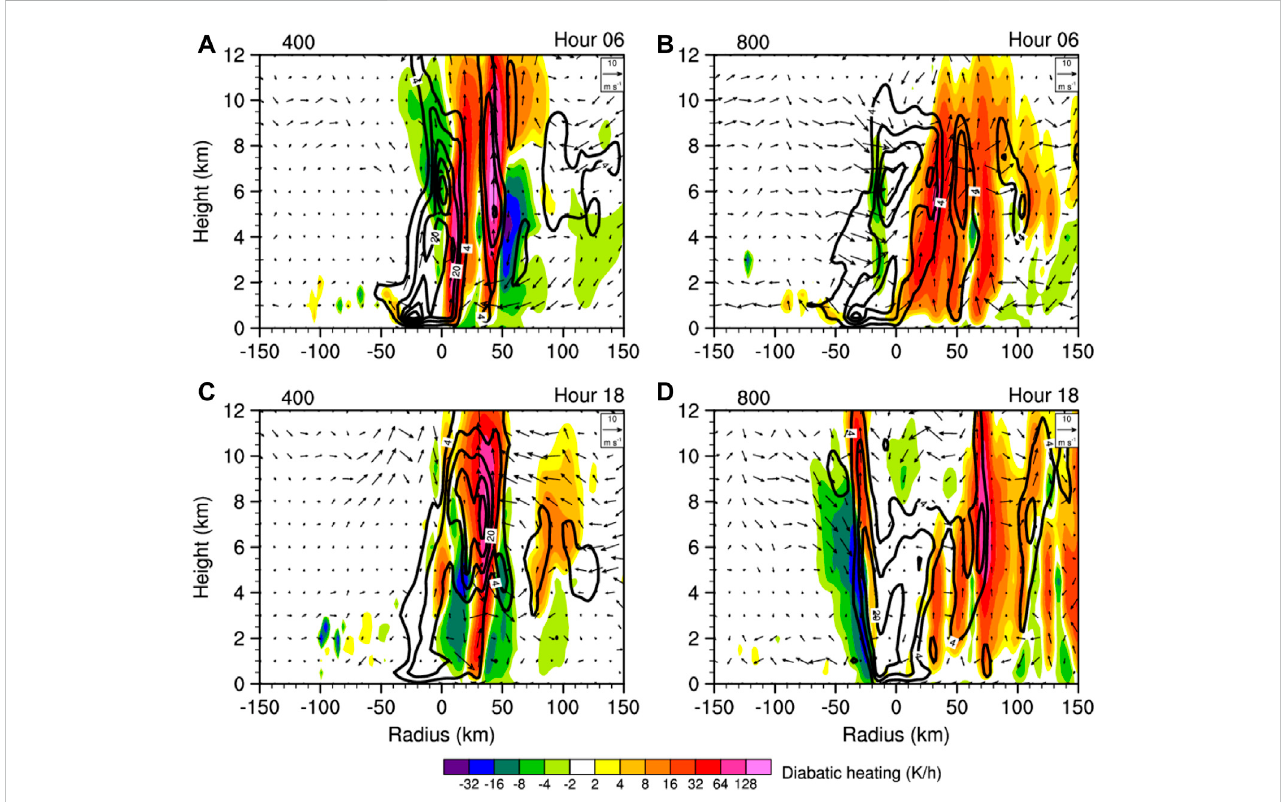
Vertical section of diabatic heating (k h − 1 ) and potential vorticity (contours at 4, 12, 20, and 28 PVU) across the TC center along the vector shown in Figure 10. (A,C) Data from EXP400 at hour 6 and 18, respectively. (B,D) Data from EXP800 at hour 6 and 18,